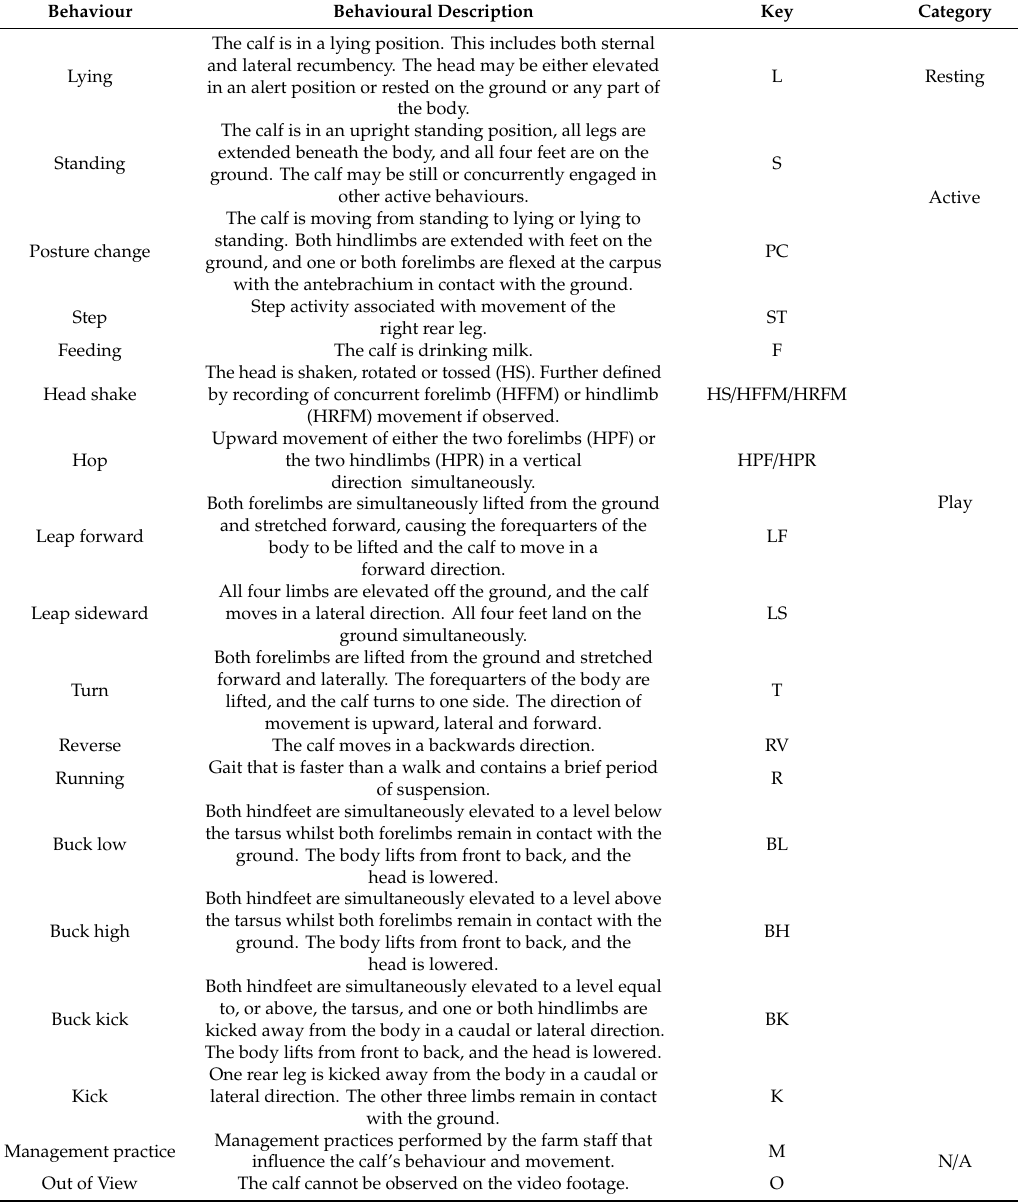
Table 1. Ethogram of calf behaviour applied to continuous visual observations [49,55]. Behaviour Behavioural Description Key Category